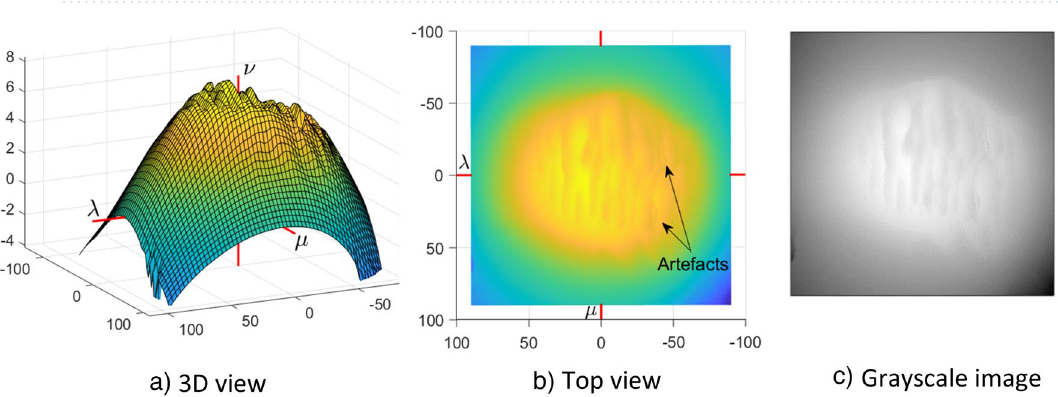
Figure 3. Symphyseal surface from Fig. 1b) in the proposed coordinate system. ( a ) 3D view of the symphyseal surface after the transformation. ( b ) Top view of the symphyseal surface after the transformation. ( c ) The grayscale image generated from the projection of transformed data into the regular